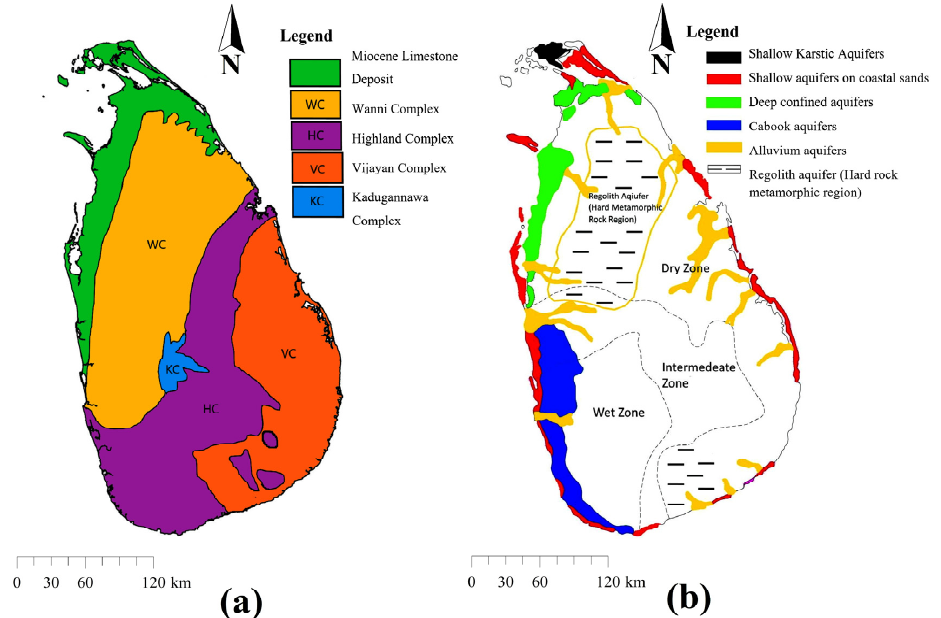
Figure 2. ( a ) Major geological zones in Sri Lanka [19,20]; ( b ) Different types of aquifer systems